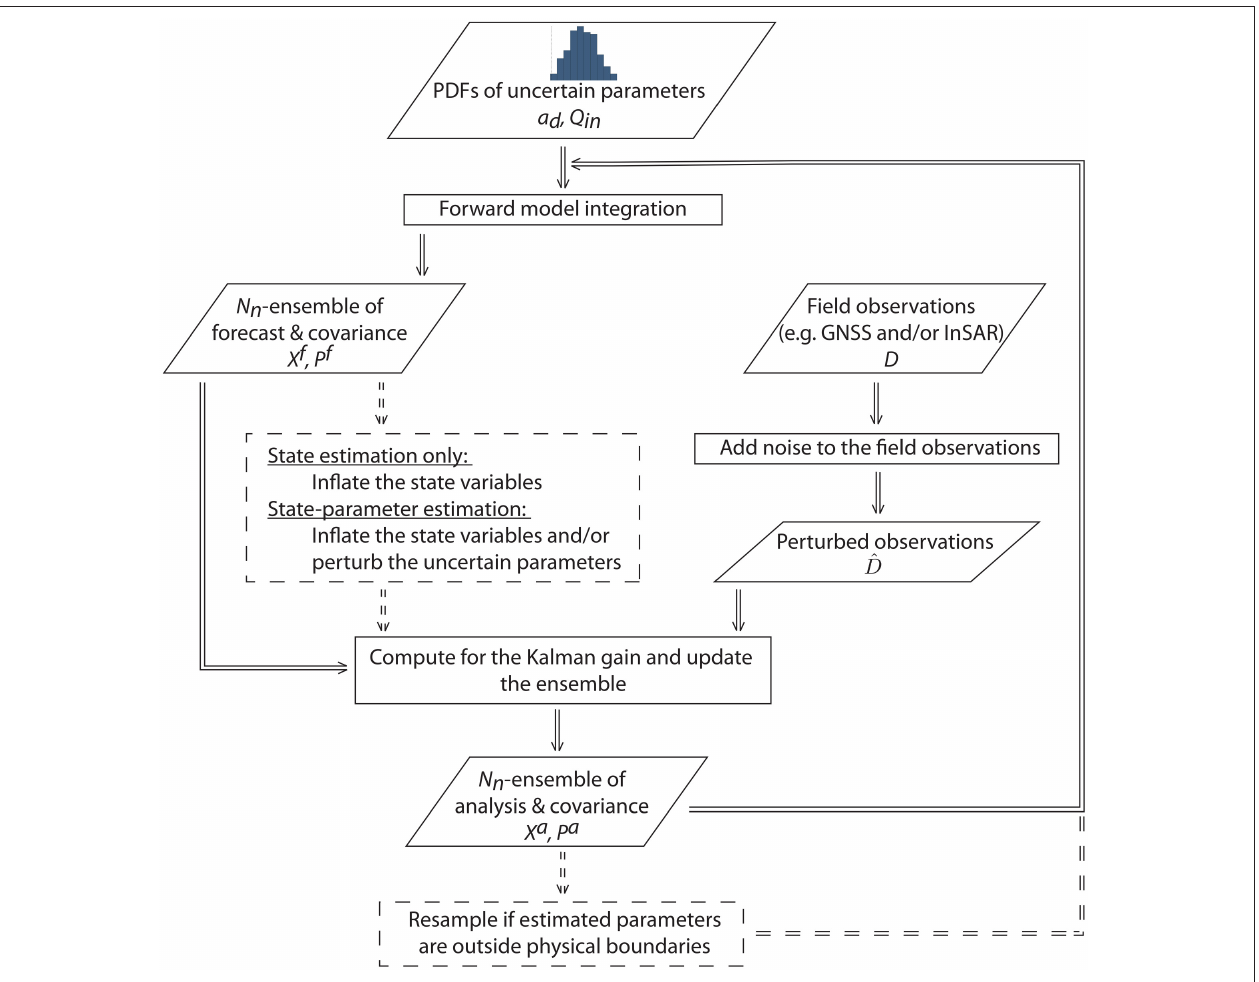
FIGURE 2 | The step-by-step EnKF strategy that we implemented in this study. The broken borders and lines imply that the step is